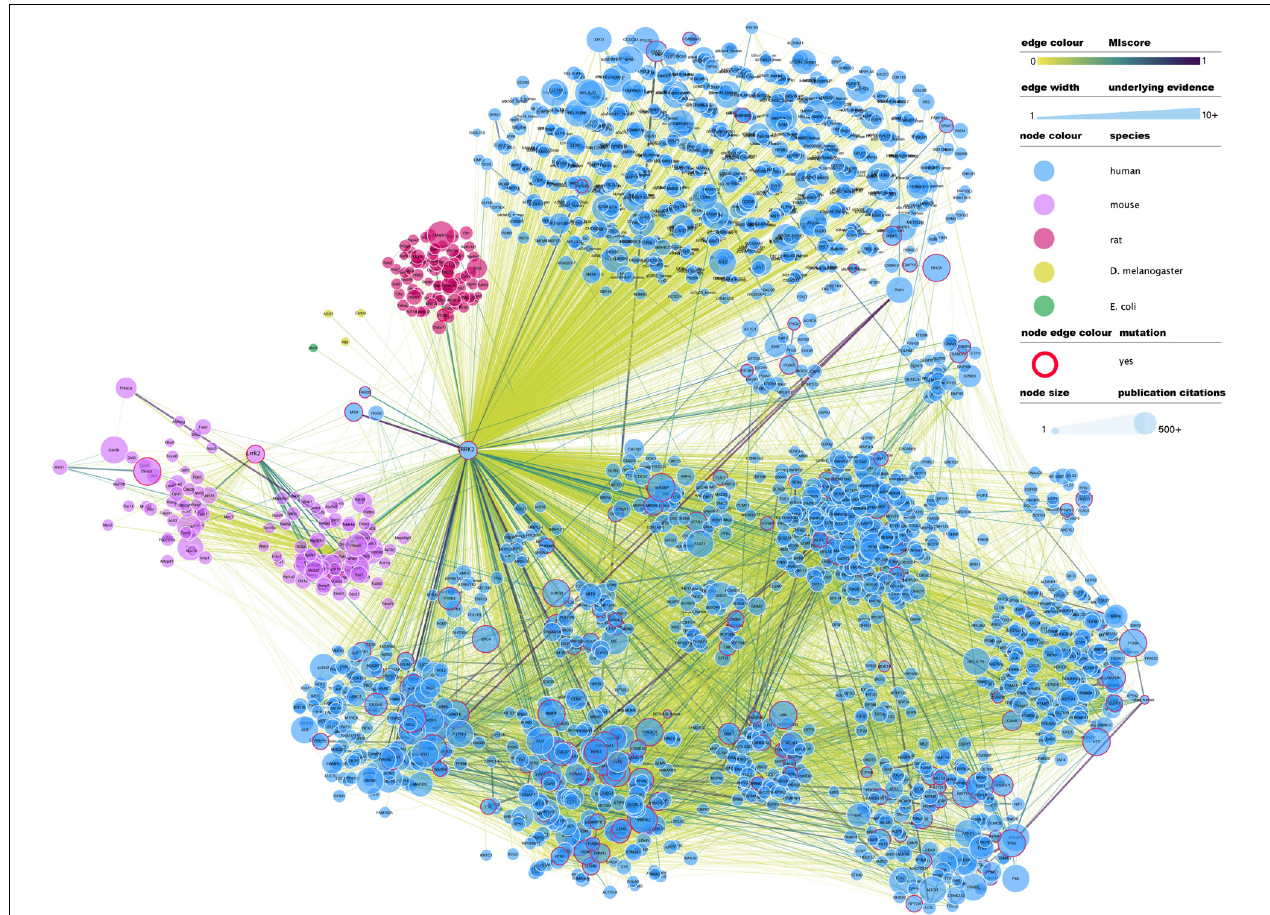
FIGURE 1 | Full LRRK2 interactome as extracted from the IntAct database. Edges represent composite of multiple physical interaction evidence. Interactions between LRRK2 interacting partners have been also added and dimmed to emphasize connection to LRRK2 specifically and roughly interconnected communities have been clustered together. Node size has been mapped to the number of publications in which that protein/gene has been mentioned according to NCBI gene2pubmed table (available at ftp://ftp.ncbi.nih.gov/gene/DATA/gene2pubmed.gz and downloaded on 18/11/2019). Red-rimmed nodes represent proteins with annotations about mutations affecting interaction outcome in IntAct. For the rest of the visual features, see in-figure legend. An interactive and downloadable version of this network can be found at